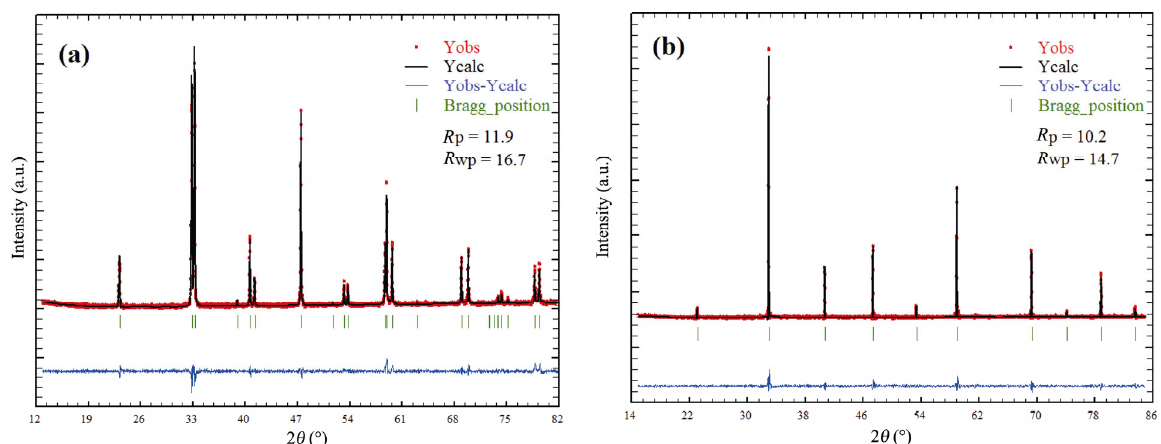
Fig. 3 Rietveld refinement results of XRD patterns for (a) La 0.95 Sr 0.05 CoO 3 and (b) La 0.3 Sr 0.7 CoO 3 . The experimental data are shown as dots; the global fitting profile and the difference curve are shown as solid lines; the calculated reflection positions are indicated by stick marks.